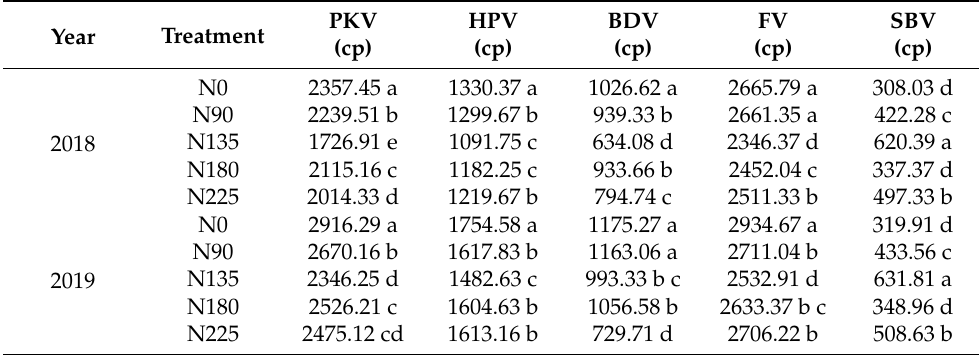
Table 3. The effect of different nitrogen application rates on the physical and chemical properties of rice.